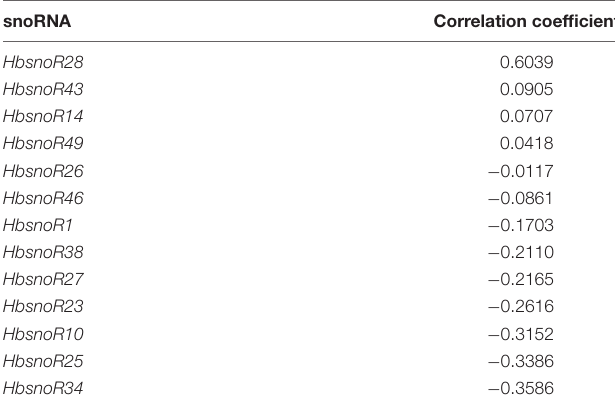
TABLE 5 | The Spearman correlation coefficient between the expression of 13 latex-yield-related small nucleolar RNAs (snoRNAs) and latex regeneration